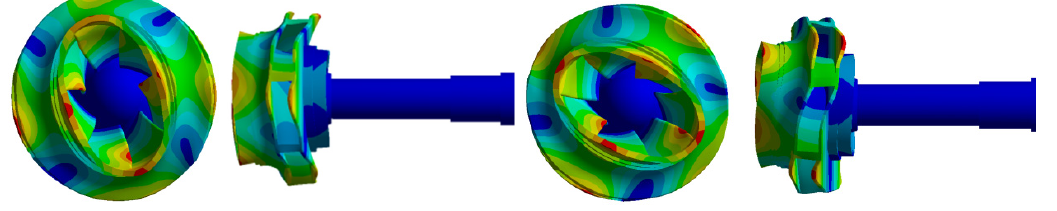
The Fore eight modes of case B are given in Figure 15.